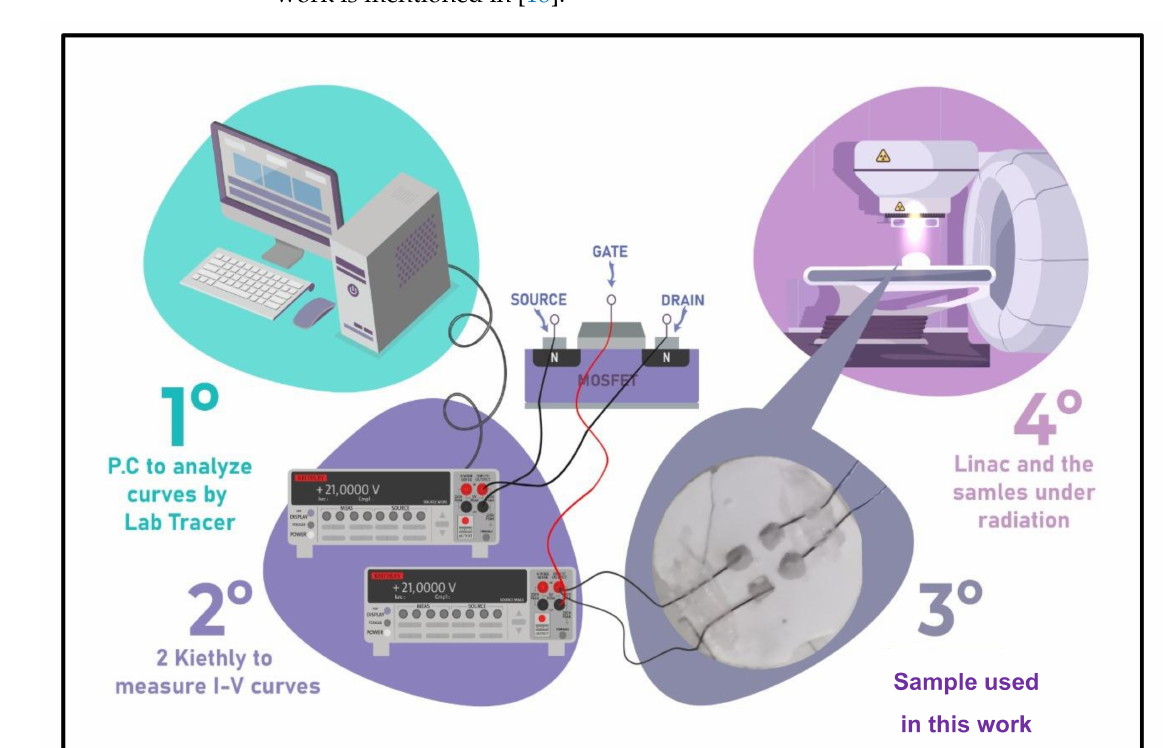
Figure 1. The connection used in this work for